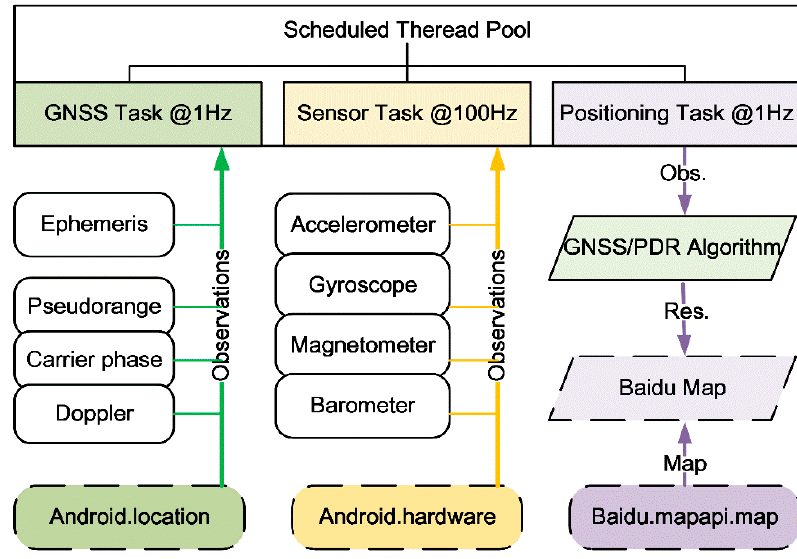
Figure 3. The architecture of the Walker application.